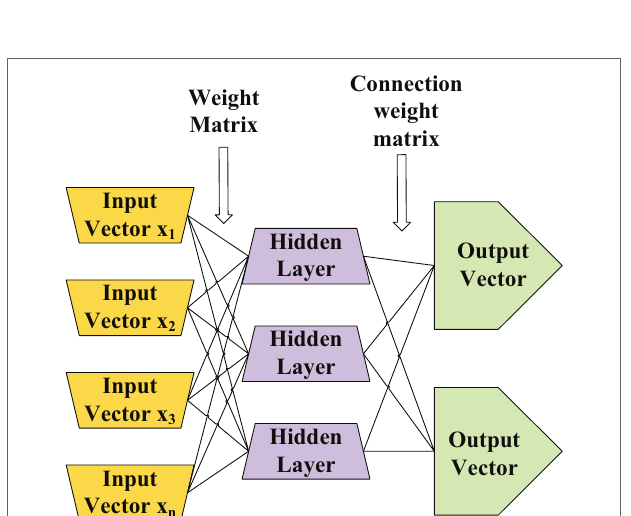
FIGURE 6 | Single-layer structure of neuron unit.